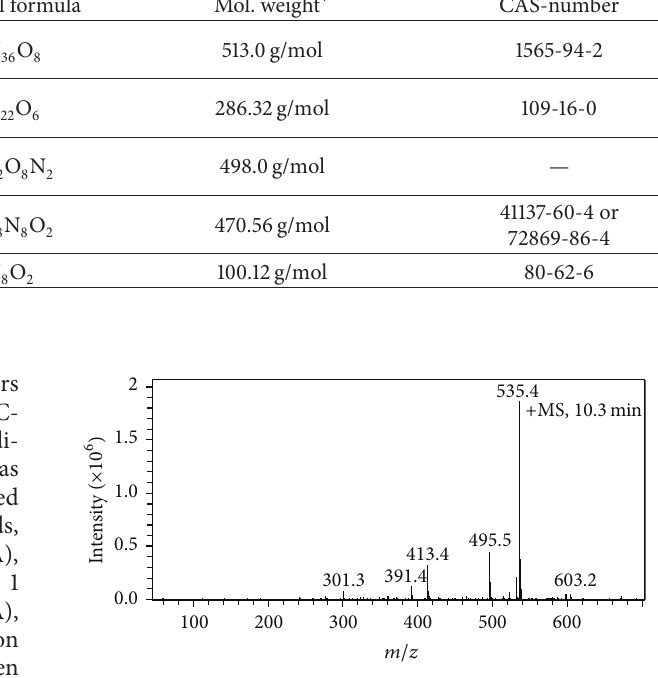
Figure 1: Detection of ions’ traces through LC-MS/MS (e.g.,